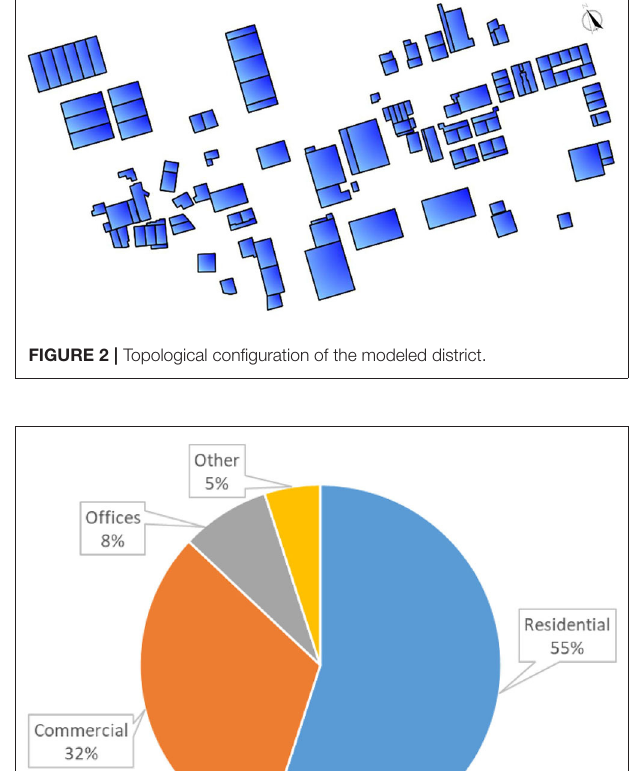
Frontiers in Sustainable Cities |